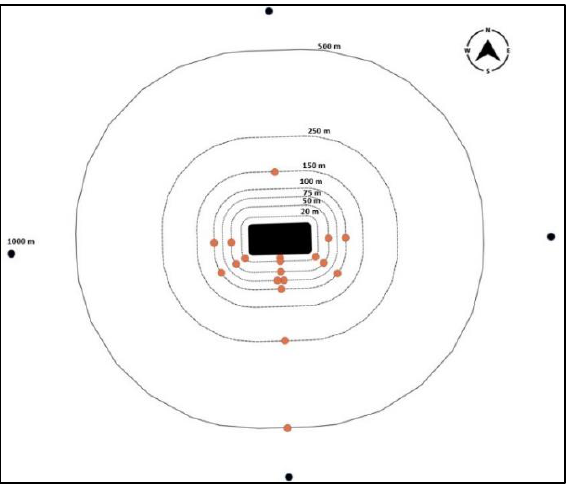
Figure 2. Seawater sampling sites monitored from 2010 to 2015 at several distances from the LNG terminal. Sampling sites at 1000 m (black dots) are not in scale.